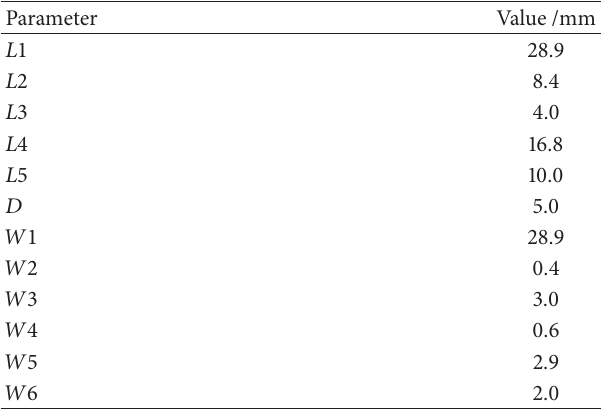
Table 1: Dimensions of proposed